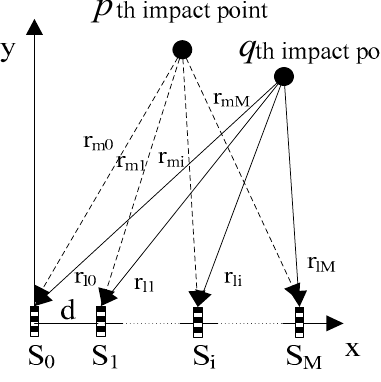
Figure 1. Localization algorithm.